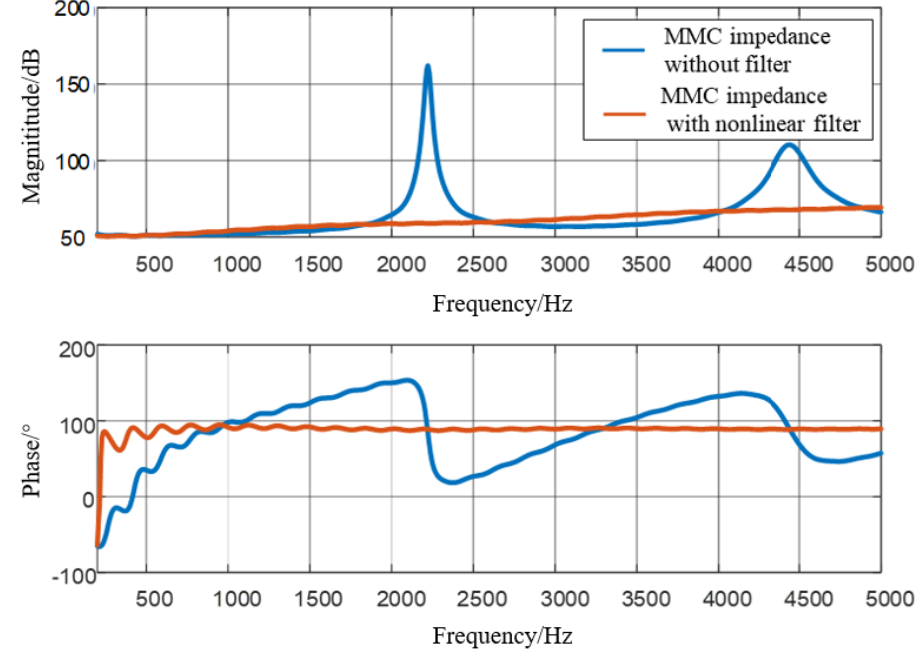
Figure 16. MMC impedance with/without nonlinear low-pass filter.